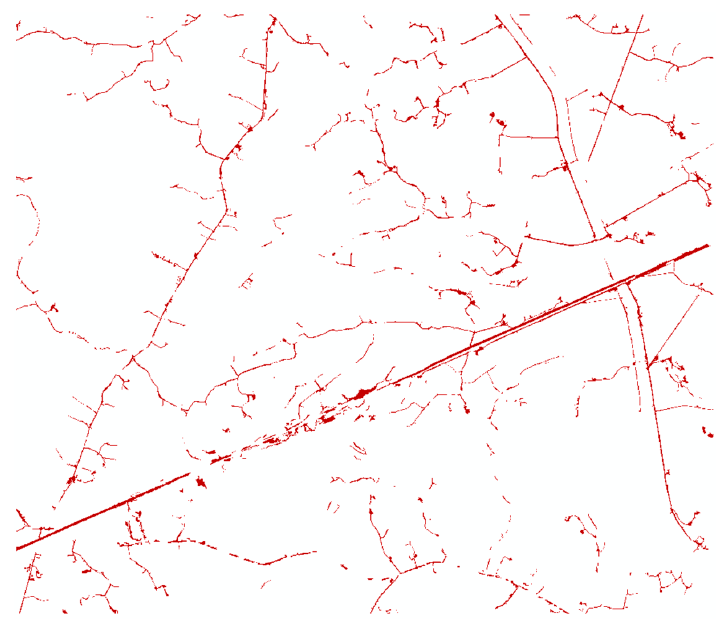
Figure 15. Road extraction result of the object-oriented classification method.